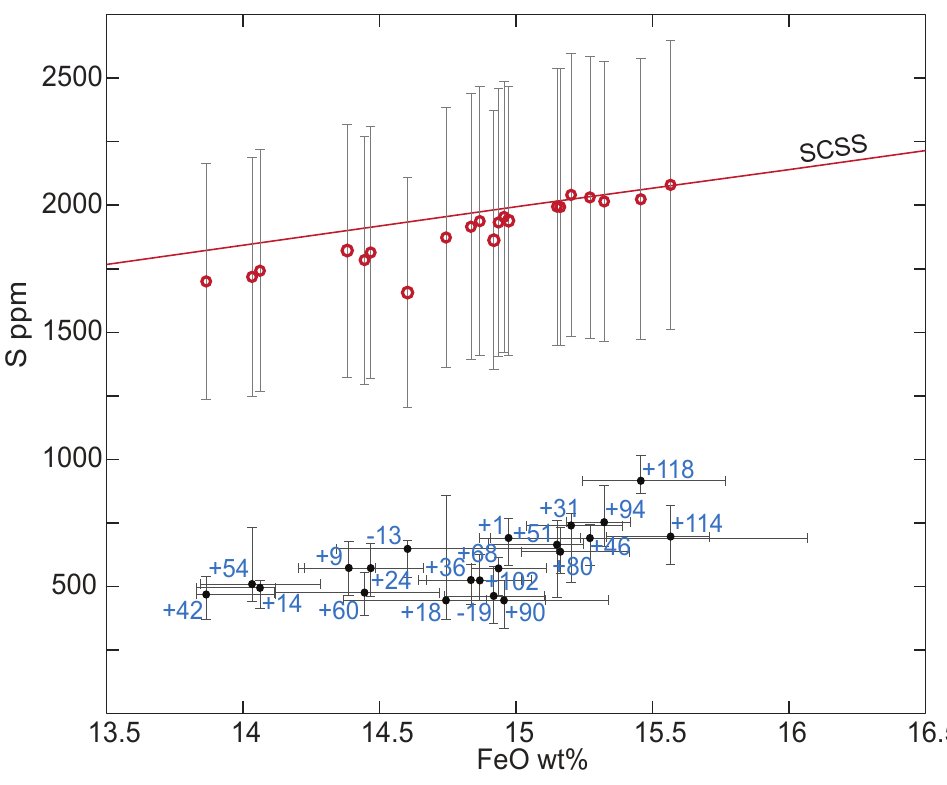
Figure 14: Sulfur concentrations (ppm) of the Fur ashes plotted as a function of FeO (wt %). Each sample is labelled with ash number, with a dot showing average value and crosses indicating 25 and 75 quantile for X- and Y-axis. Red circles indicate the modelled ideal value for SCSS for a FeS-NiS-CuS 0.5 saturated MORB melt [Smythe et al. 2017]. Modelled using an average Northern Mid-Atlantic Ridge (NMAR) sulfide liquid composition [Keith et al. 2017], average silicate composition for each Fur ash layer, temperature of 1130 °C, and pressure 0.1 GPa. Vertical lines indicate error (1 σ ) for each modelled SCSS. Data in Table S3, Supplementary